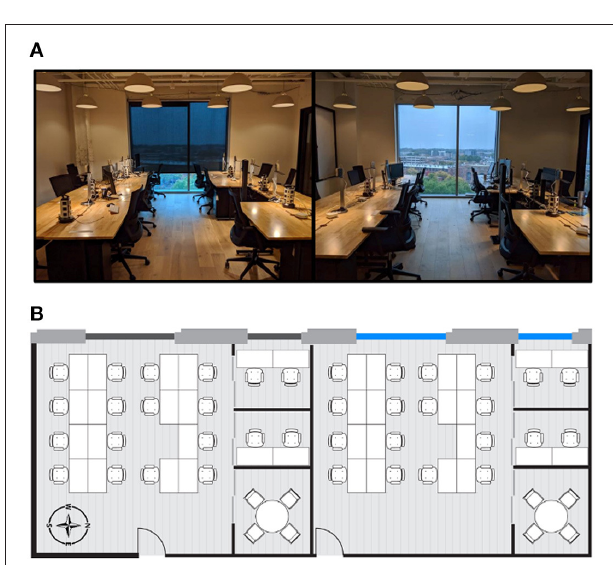
FIGURE 2 | (A) Photographs of the two study conditions: Roller Shades (left) and EC Glass (right). (B) Furniture layout of the two study conditions: Roller Shades (left) and EC Glass